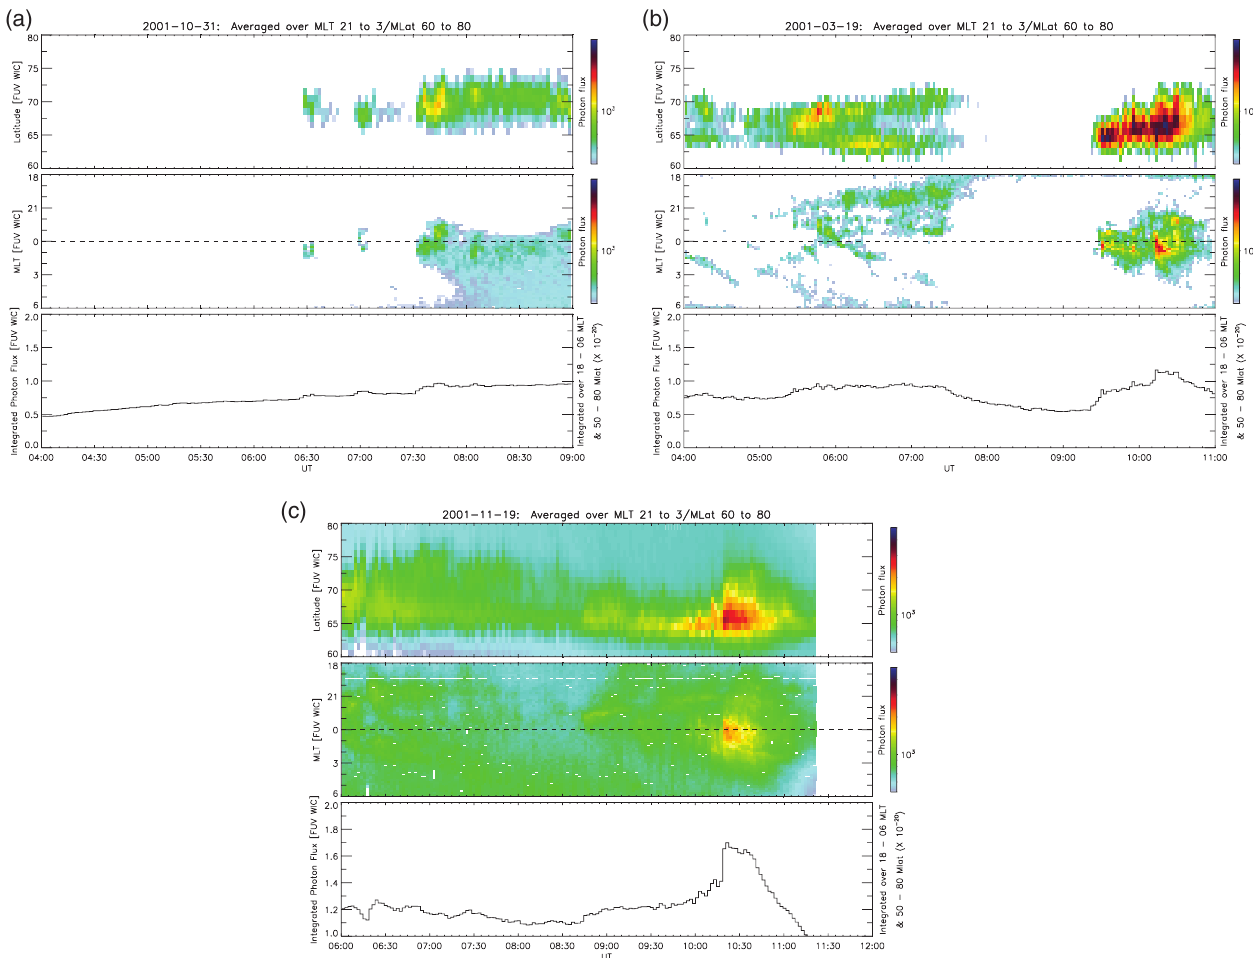
Figure 3. Keogram for 31 October 2001, 19 March 2001 and 19 November 2001 constructed from individual WIC images obtained by IMAGE. The top panel shows the precipitated fluxes as a function of the magnetic latitude (MLat), the middle panel as a function of the magnetic local time (MLT) and the bottom shows integrated photon fluxes from 18 to 06MLT. During periods without substorms, only quiet arcs and pseudo-breakup auroras are